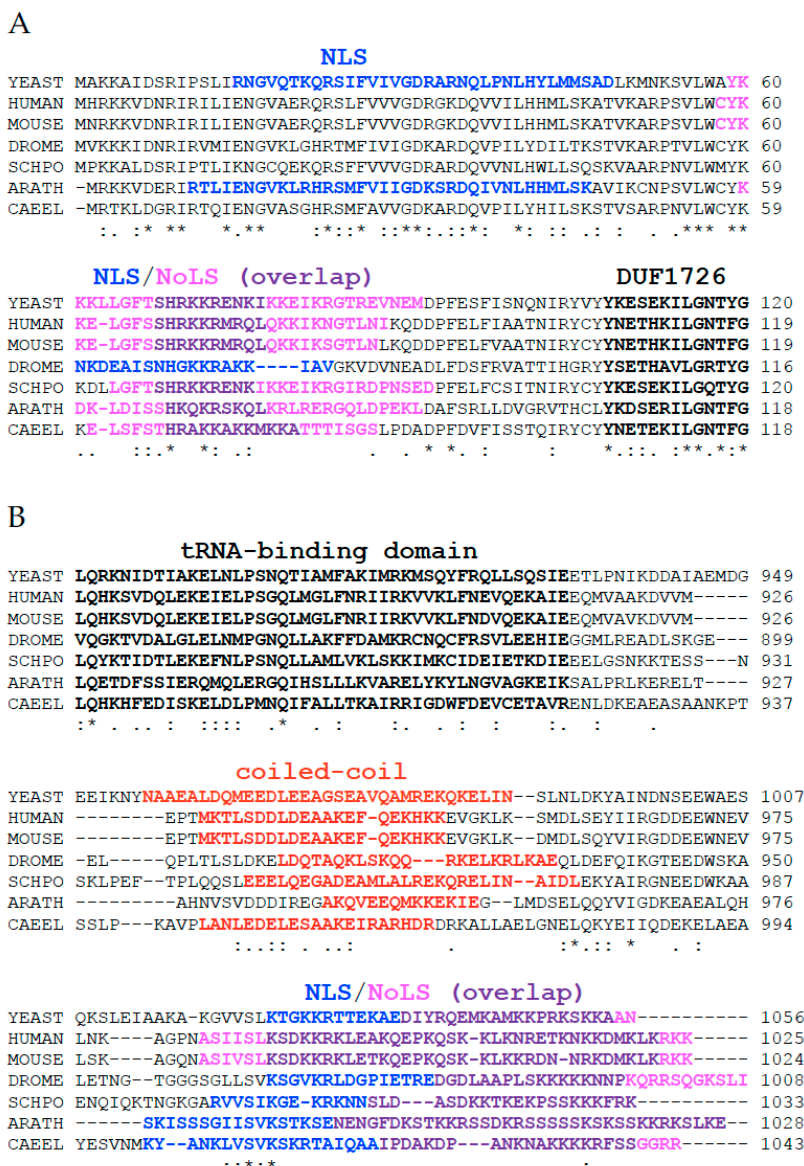
Figure 3. Alignment of Kre33/NAT10 from different species. Sequences from yeast, human, mouse, D. melanogaster (DROME), S. pombe (SCHPO), A. thaliana (ARATH) and C. elegans (CAEEL) were used to generate an alignment with Clustal Omega [102]. ( A ) The N-terminal extension precedes the DUF1726 (black bold letters) and harbors eukaryote-specific motifs, such as the NLS (blue) and the NoLS (magenta); overlapping NLS/NoLS sequences are in purple. ( B ) The C-terminal extension follows the tRNA-binding domain (black bold letters): it contains a coiled-coil motif (red) and finishes with the NLS (blue)/NoLS (magenta); the NLS/NoLS overlap is in purple. The putative NLS, NoLS and coiled-coil motif were identified with cNLS mapper [103], NoD [104] and COILS [105].